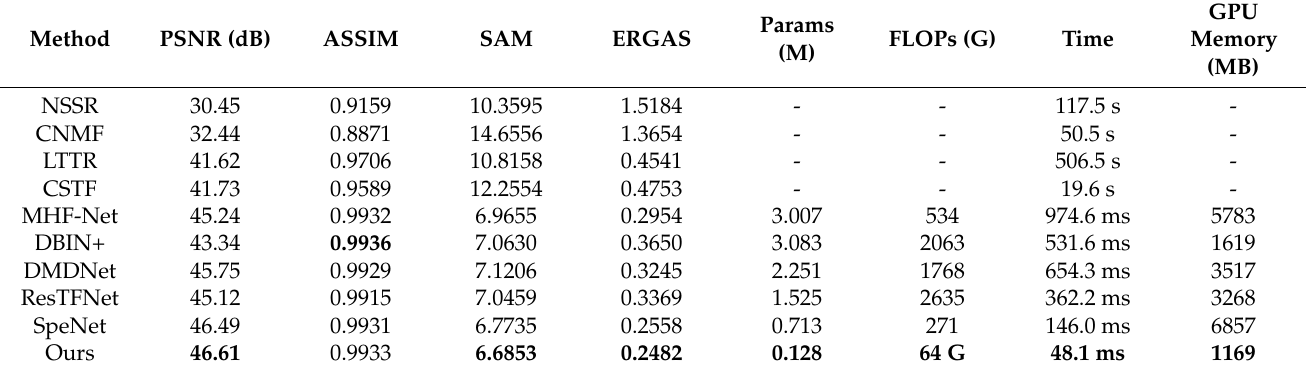
Table 3. Experiment with ten PS methods on the CAVE dataset. The best performance is shown in bold.